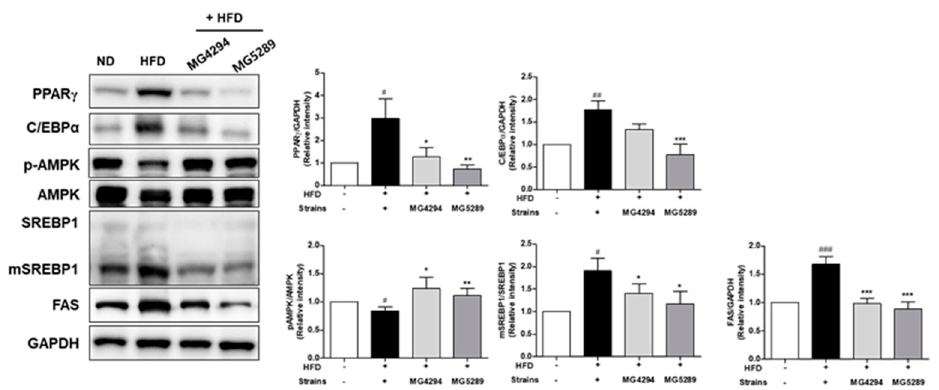
Figure 7. L. fermentum MG4294 and L. plantarum MG5289 modulate lipid metabolism-related factors in liver tissue of HFD-induced mice. The expression of p-AMPK was normalized by AMPK; all proteins except this one were normalized to GAPDH. The data are expressed as mean ± SEM ( n = 6). # p < 0.05, ## p < 0.01, and ### p < 0.001 compared with ND group; * p < 0.05, ** p < 0.01, and *** p < 0.001 compared with HFD-group.